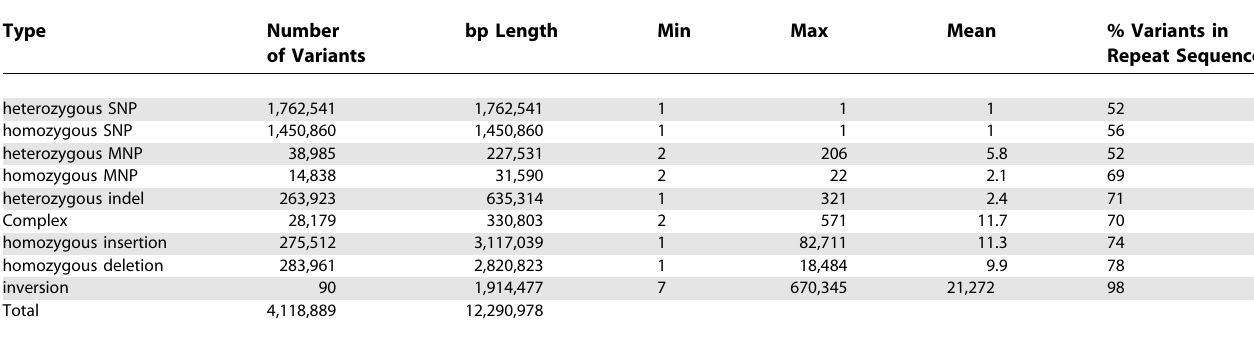
Table 6. Summary of Variant Types Identified in the HuRef Genome Assembly